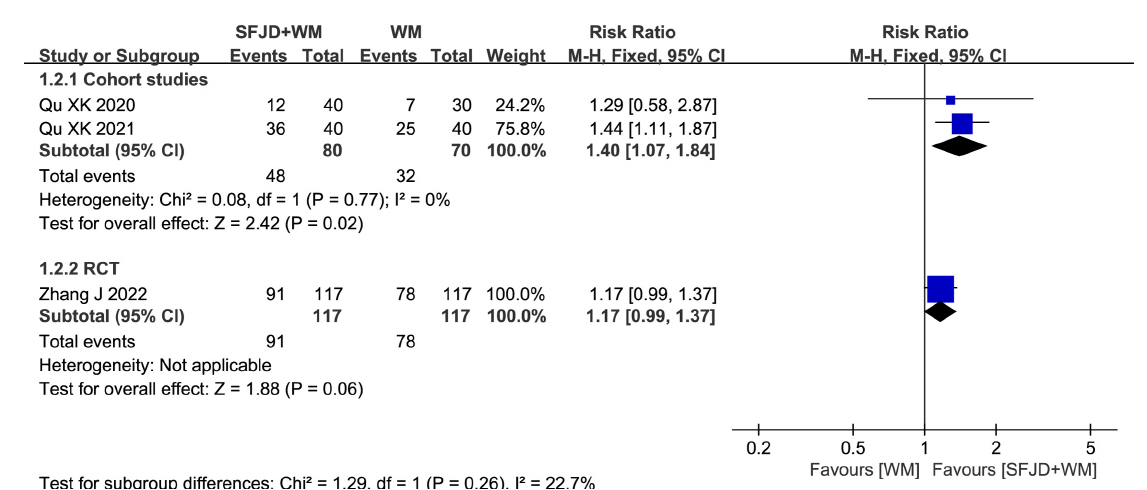
FIGURE2 Meta-analysis of nucleic acid conversion rate in the SFJD + WM group vs. the WM group in COVID-19 patients.